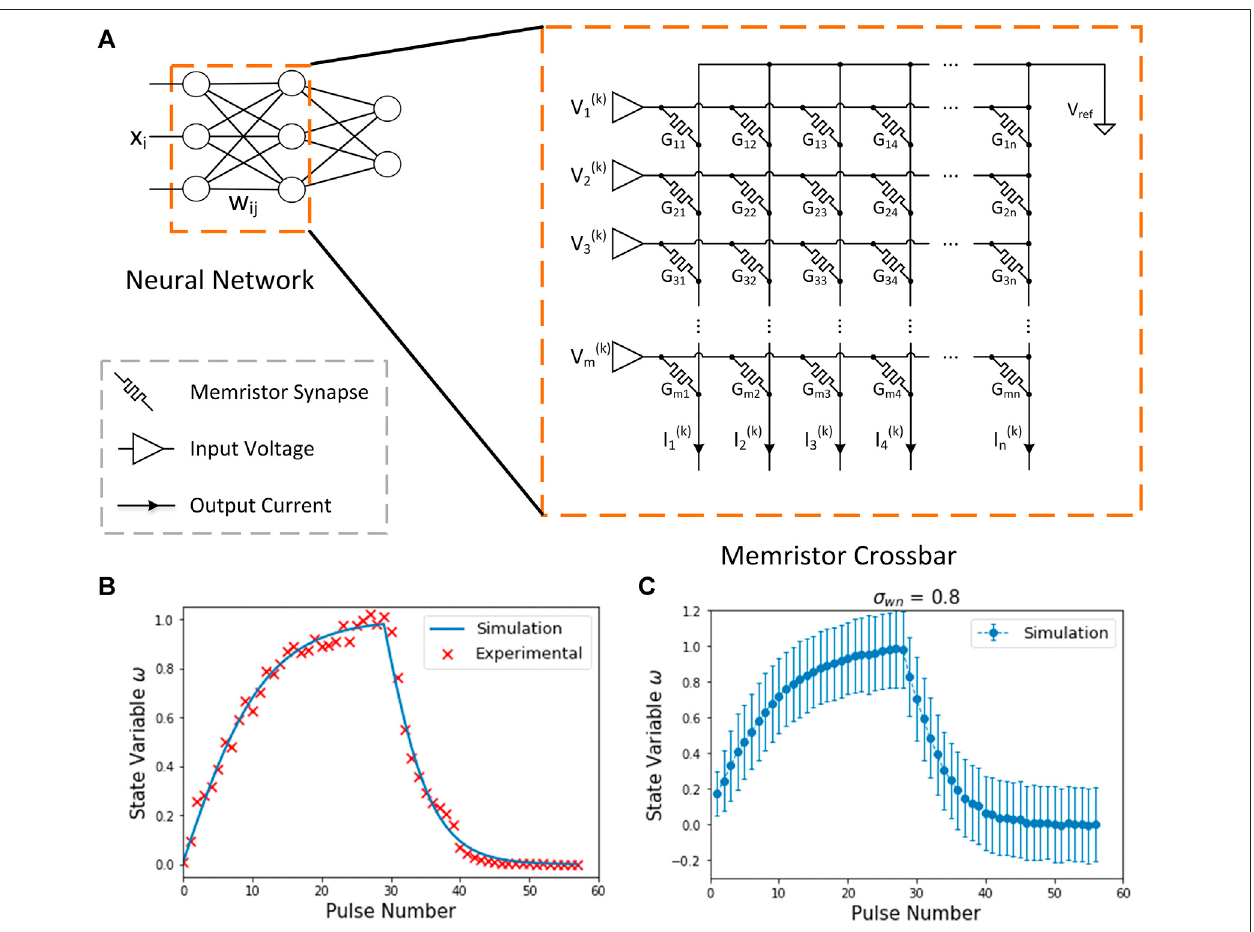
FIGURE 2 | (A) Memristor Crossbar. The weights of neural network are mapped to memristor crossbar arrays as conductance G ij . The inputs and outputs are represented by the voltages V i and the currents I i . (B) Experimental and simulated updates of TaO x /HfO 2 /Ta bi-layered memristors. (C) Standard variation of simulated updates with write noise.